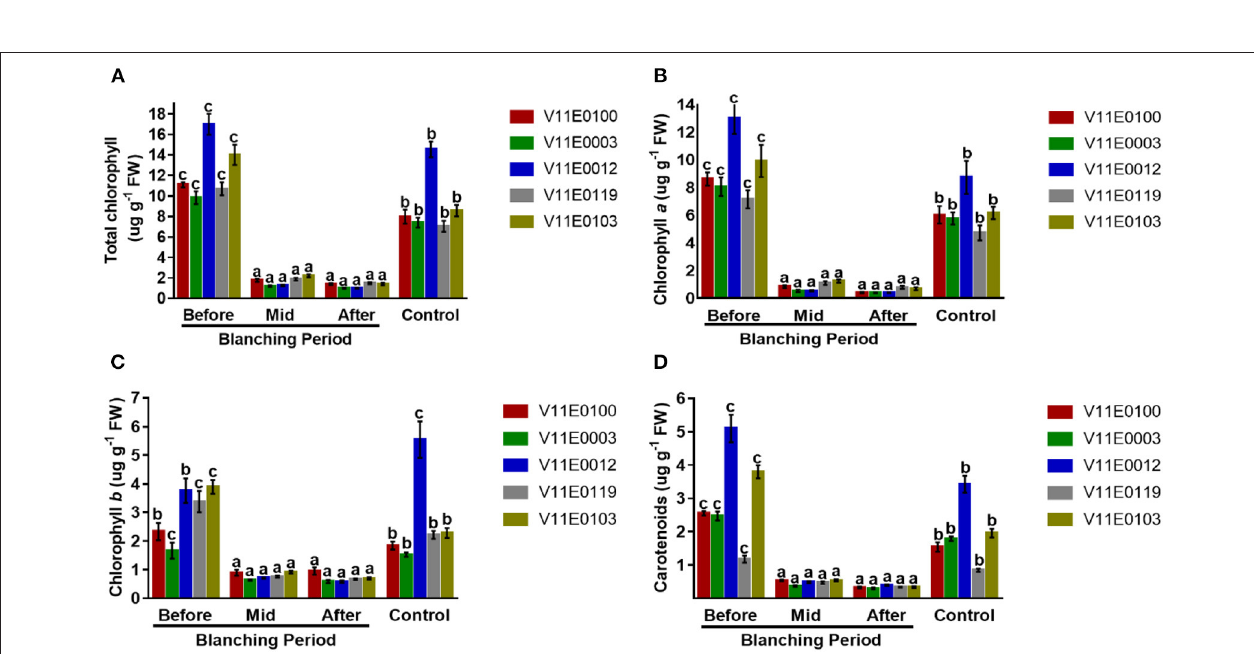
FIGURE 3 | Effect of blanching on the photosynthetic pigments of the stem in five water dropwort cultivars. (A) Total chlorophyll content, (B) chlorophyll a content, (C) chlorophyll b content, and (D) carotenoids concentration. Four types of samples were used for analysis; Pre-blanching, Mid-blanching (20 days), Post-blanching (40 days), and Control (grown under normal conditions). Different letters indicate a significant difference ( P < 0.05) among the treatments according to the Tukey test. Values are means ± SE.